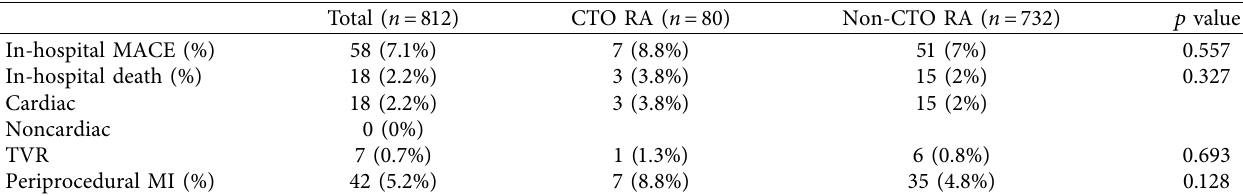
Table 3: In-hospital outcomes.